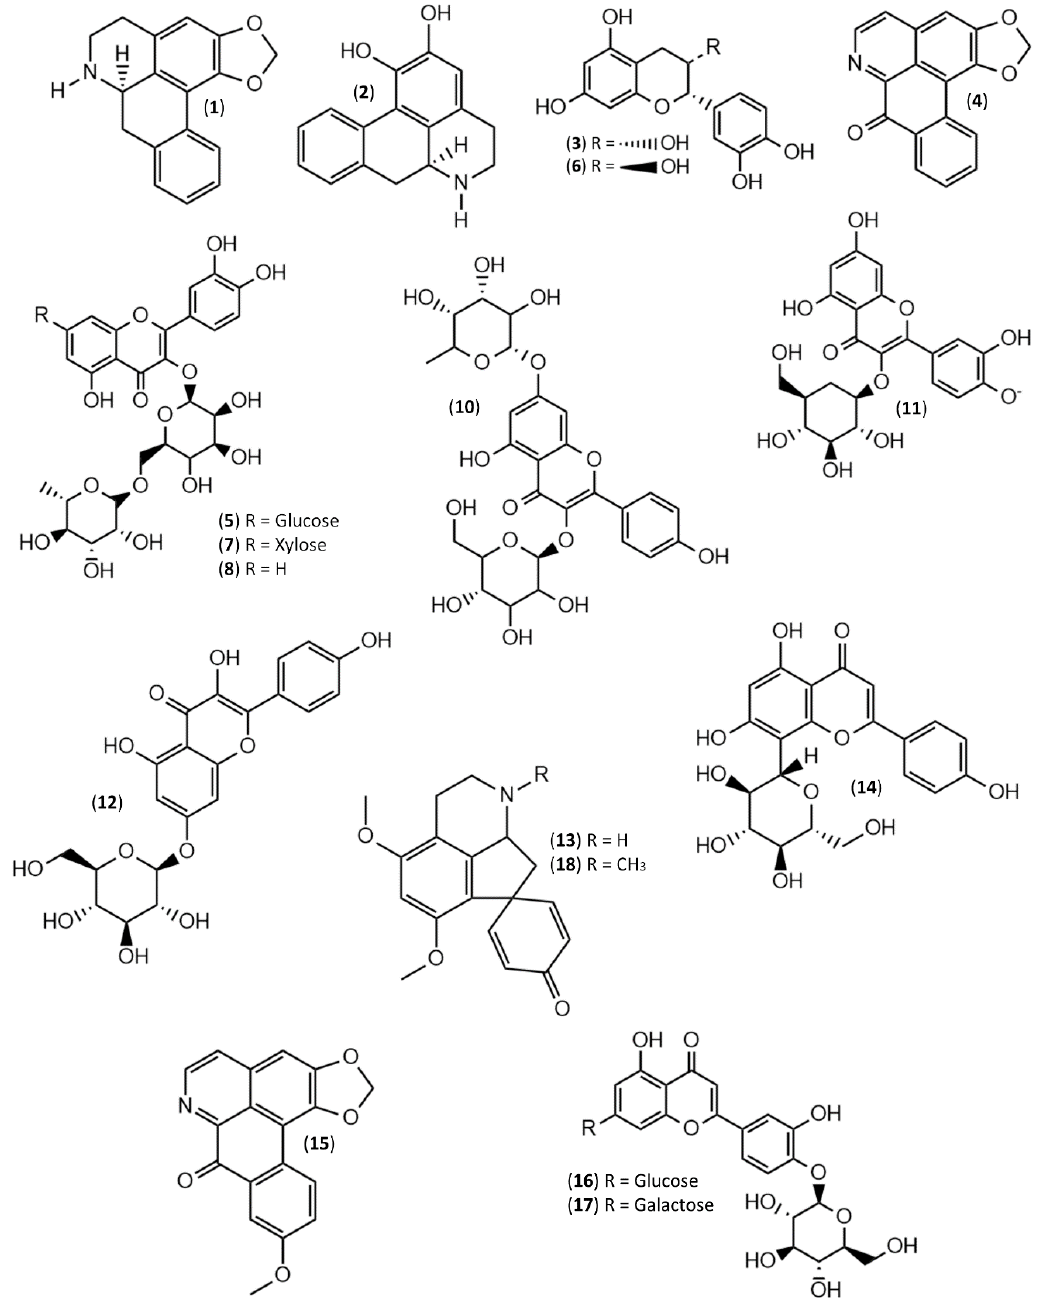
Figure 1. Chemical Structures of the phenolic and alkaloid compounds characterized and quantified in the seven extracts of Cherimoya and Atemoya